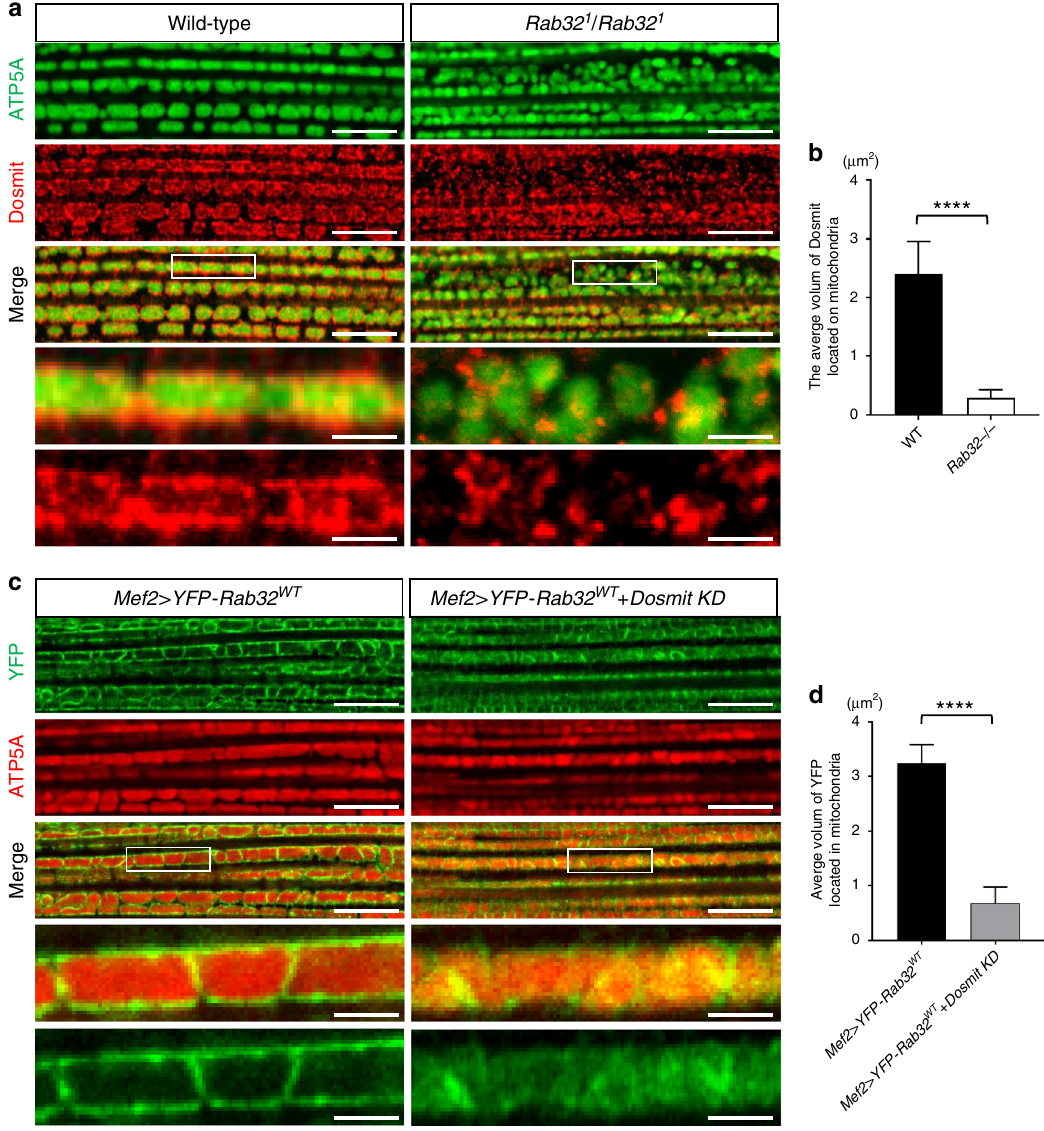
Fig. 9 Rab32 and Dosmit localization on mitochondria is mutually dependent. a , b Rab32 mutants show an improper localization of Dosmit compared to wild-type fl ies (mean ± SD). Dosmit: red; ATP5A: green. N = 123 and 215 from left to right bars. Statistical test: two-tailed student ’ s t -test (**** p < 0.0001). c , d Dosmit knockdown also signi fi cantly disrupted Rab32 localization (mean± SD). YFP-Rab32: green; ATP5A: red. N = 102 and 191 from left to right bars. Statistical test: two-tailed student ’ s t -test (**** p < 0.0001). Scale bars: 10 μ m. Source data are provided as a Source data fi